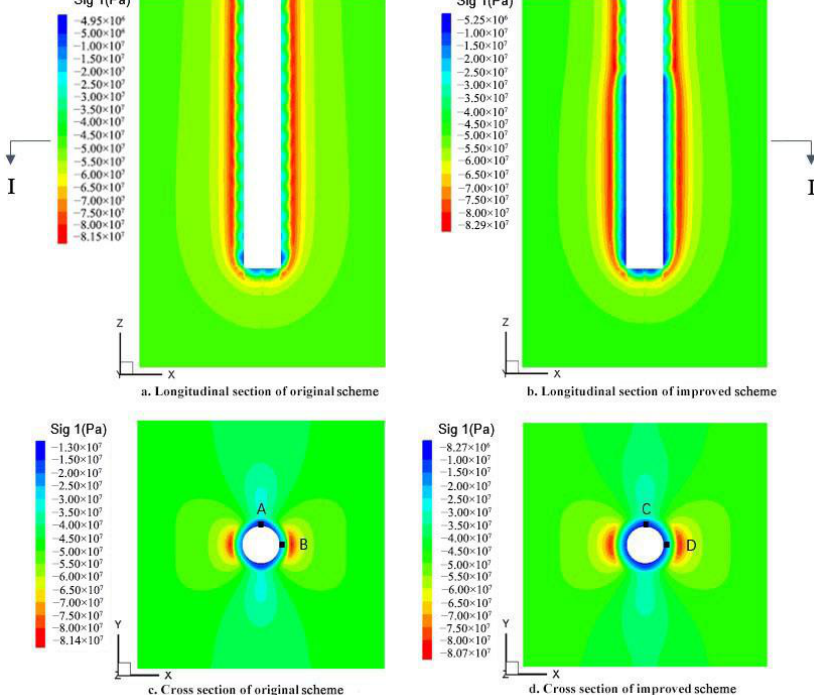
Figure 12. Major principal stress for different support construction Figure 12 . Major principal stress for different support construction schemes.